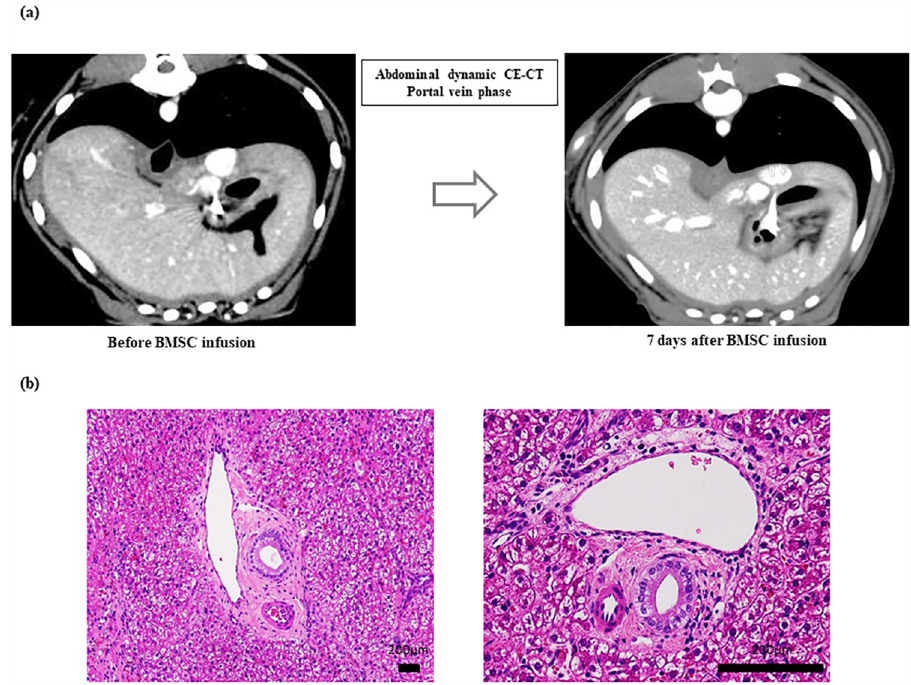
Fig 7. Contrast-enhanced computed tomography (CE-CT) and photomicrographs of liver tissue samples after BMSC application. (a) After the infusion of CE-CT, no evidence of liver infarction and the absence of major portosystemic shunts (PSS) were observed. (b) Arterial embolization and biliary necrotic images were not observed in the liver tissues following hematoxylin and eosin staining.